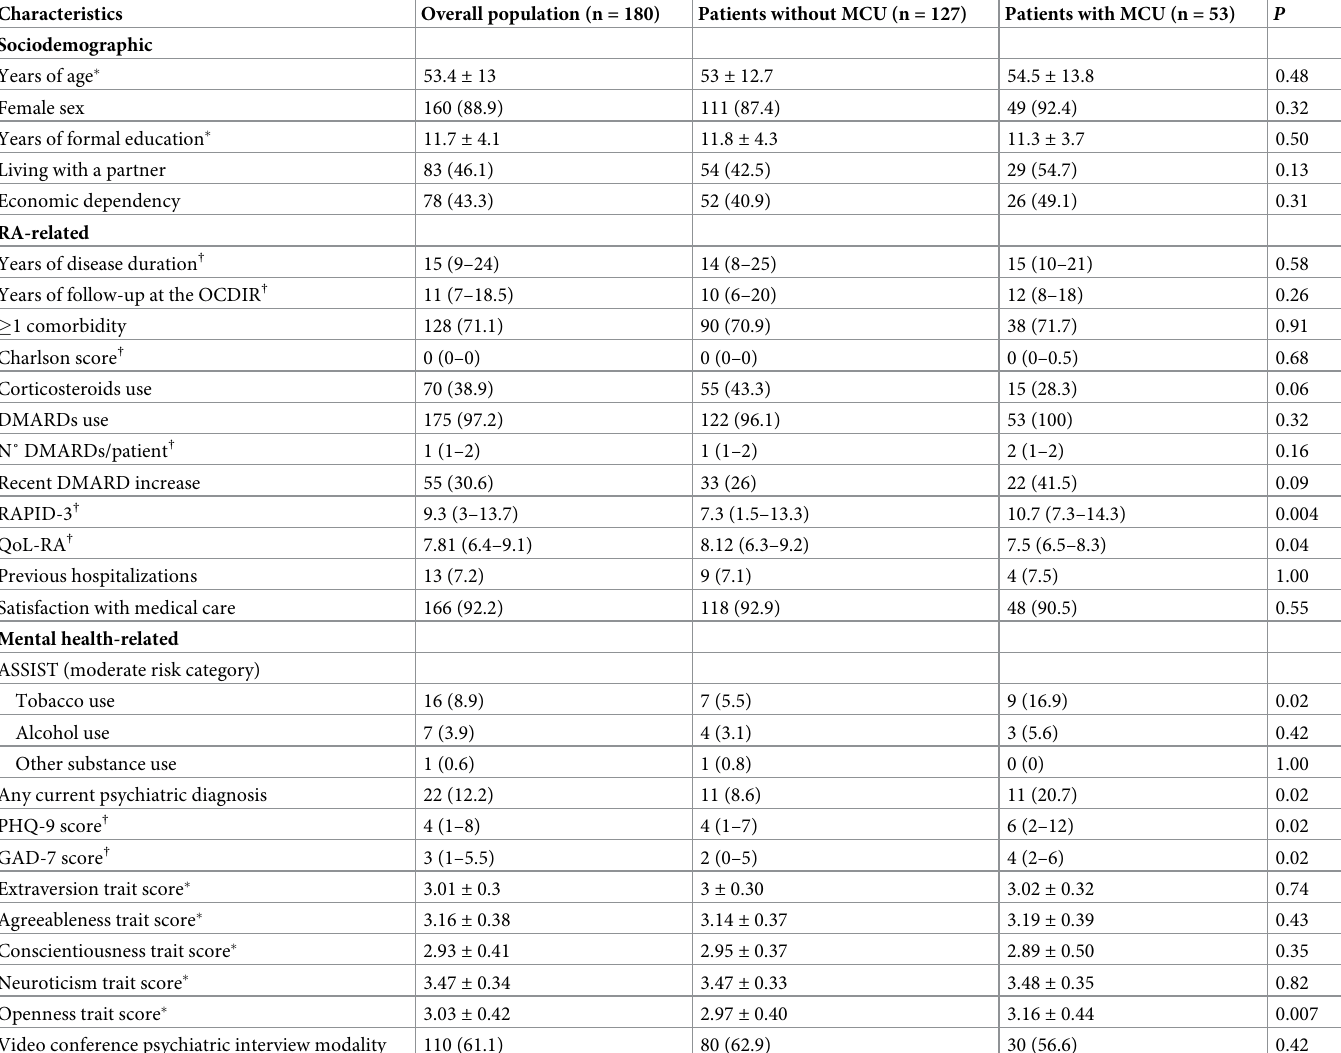
Table 1. Population characteristics and comparison between patients with and without medicinal cannabis use (MCU).